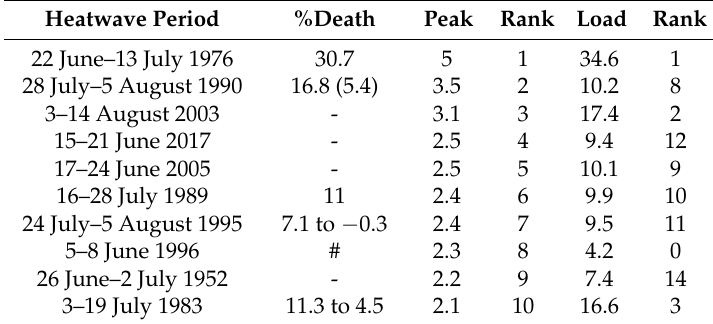
Table 5. Top ten ranked peak [ ] and load [ ] for London (Heathrow Airport, 1921 to 2018). Percentage change in deaths associated with heatwave period [42,43] (p. 370). # no heatwave was identified by Hajat et.al. [41] (p.